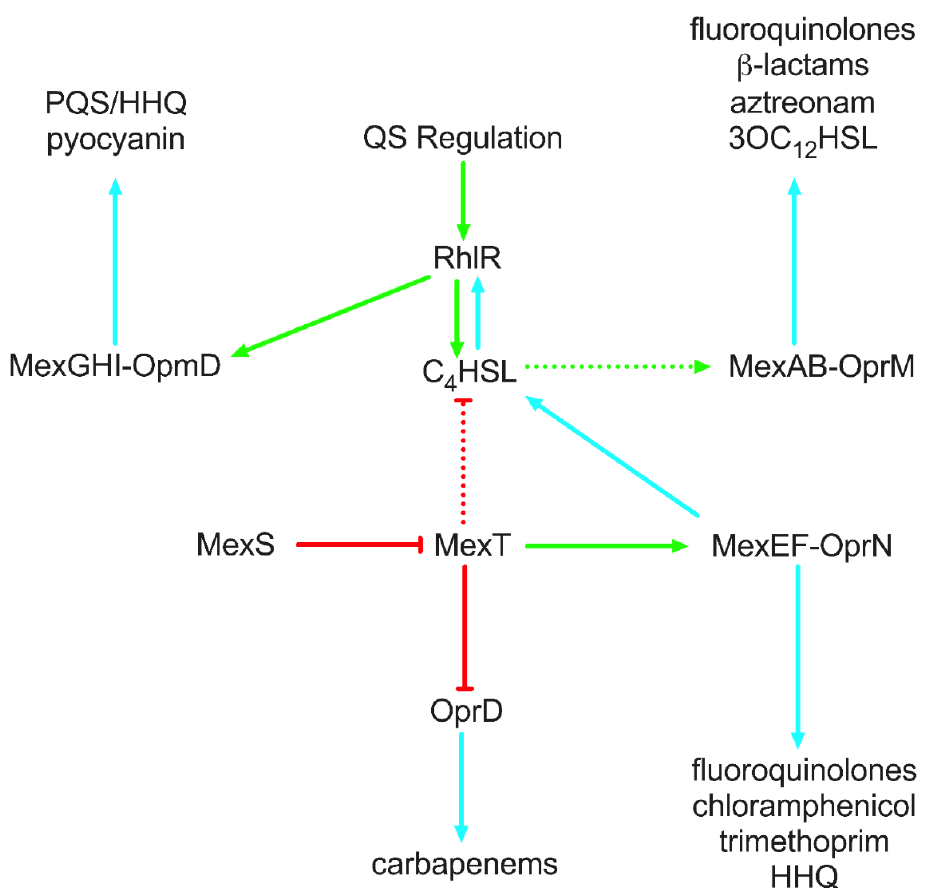
Figure 2. The interplay between QS and intrinsic mechanisms of antibiotic resistance. Select regulators of efflux pump and porin function as they relate to QS regulation. RhlR binds to C 4 HSL (blue arrow) and activates the transcription of the synthase responsible for C 4 HSL (green arrow). RhlR and C 4 HSL directly regulate the expression of mexGHI - opmD (green arrow) and indirectly regulates mexAB-oprM expression via an unknown mechanism. MexGHI-OpmD plays a role in secreting important virulence factors (blue arrow). MexAB-OprM expels fluoroquinolones, β-lactams, aztreonam, and AI signaling from the cell. MexT indirectly represses (dotted red bar) the production of C 4 HSL, while simultaneously upregulating the expression of mexEF-oprN . MexEF-OprN expels C 4 HSL, fluoroquinolones, chloramphenicol, trimethoprim, and HHQ from the cell (blue arrows). MexT also represses oprD expression, which contains a carbapenem binding pocket (blue arrow). Like the MexEF-OprN efflux system, the MexCD-OprJ system was implicated in QS AI extrusion. MexCD-OprJ is repressed by NfxB, and nfxB mutant clinical isolates overexpress MexCD-OprJ [177]. Overexpression of MexEF-OprN and MexCD-OprJ is (Figure 2) [171]. Mutations in the nfxC gene and/or constitutive expression of MexT correlated to deficient production of QS-regulated virulence factors. A mexD deletion in through alteration of residue G257 caused the overexpression of the MexEF-OprN efflux a nfxB mutant restored QS mediated virulence, demonstrating that QS disruption in a system [171]. Expression of the MexEF-OprN and MexAB-OprM systems is mutually MexCD-OprJ overexpressing strain is NfxB-independent [178]. Analysis of PQS:HHQ exclusive, as MexT represses the MexAB-OprM system and nfxC mutants downregulate ratio levels in nfxBmexD mutant supernatants and cell lysates revealed deficient HHQ mexA and oprM genes. It was suggested that MexEF-OprN disrupts C 4 HSL activation of secretion in nfxBmexD mutant strains, suggesting that MexCD-OprJ mediated extrusion of MexAB-OprM, although the exact mechanism is unknown. Possibilities include: (i) HHQ disrupted the PQS system signaling. Moreover, the expression of pqsE decreased in transcriptional repression of the C 4 HSL synthase gene rhlI or (ii) MexEF-OprN-mediated strains overexpressing mexCD-oprJ , while HSL AI secretion was unaffected [178]. extrusion of C 4 HSL. The former explanation is supported by evidence that MexT antagonizes C 4 HSL production while promoting MexEF-OprN expression [168]. MexT is also a repressor of the OprD porin (discussed above) and its constitutive expression in